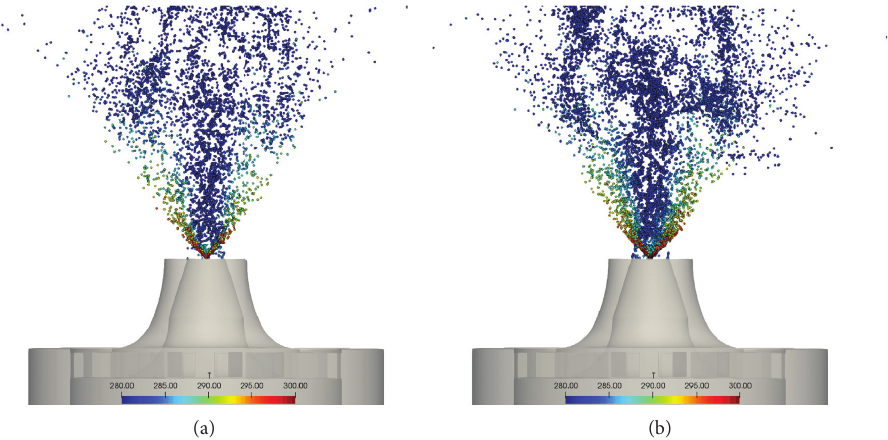
Figure 26: Droplet temperature for cases A-NR (a) and B-NR